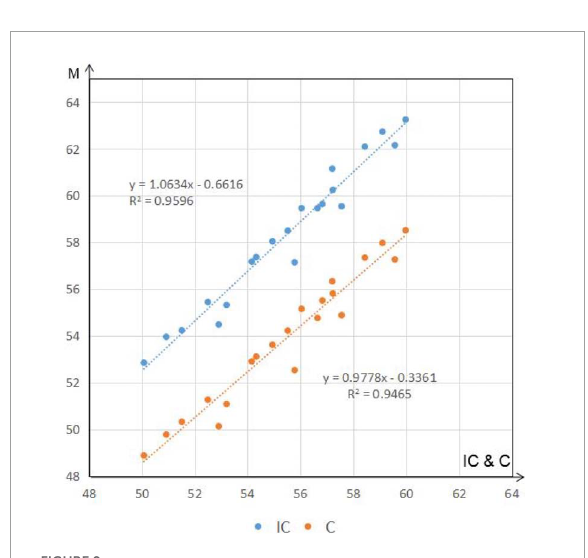
FIGURE9 Correlation of the NPP value of the improved model with the estimated value of the CASA model and the NPP value of the MODIS